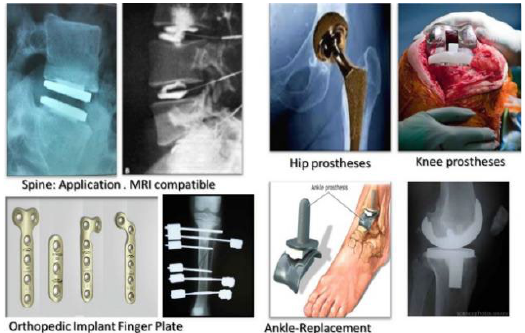
Figure 1. Metallic biomaterials for orthopedic applications reprinted with permission from Ref. [1]. ELSEVIER Copyright 2022,